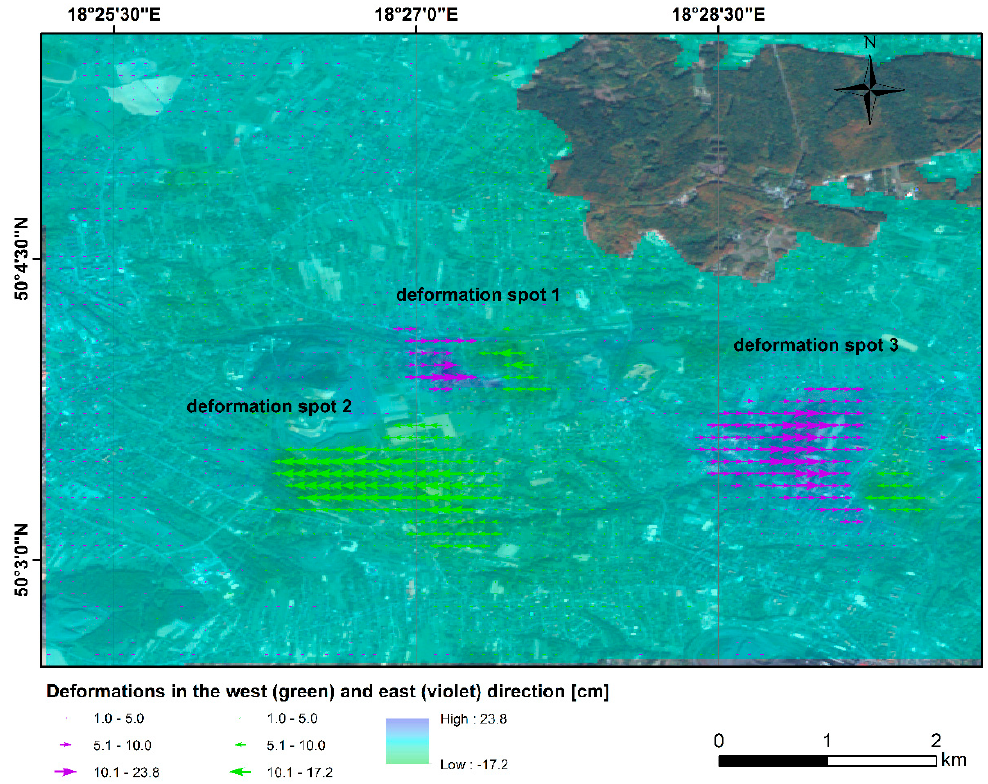
Figure 7. The final horizontal displacement map over the Rydułtowy mine between 1 January 2017 and 8 October 2018.